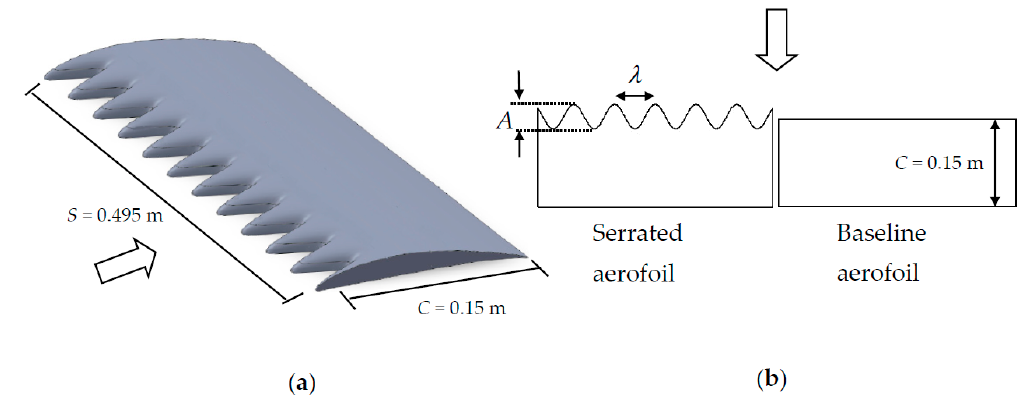
Figure 3. ( a ) Isometric drawing of the NACA 65(12)-10 aerofoil model with serrated leading edge; ( b ) comparison between a serrated aerofoil and baseline aerofoil. Table 1. Geometrical parameters of the leading edge